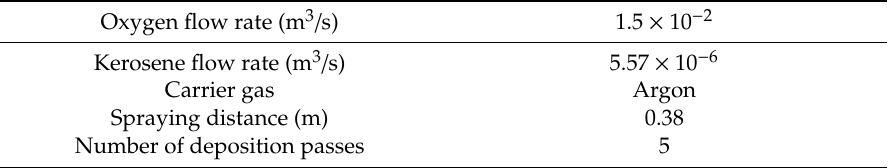
Table 2. High-velocity oxy-fuel (HVOF) spraying